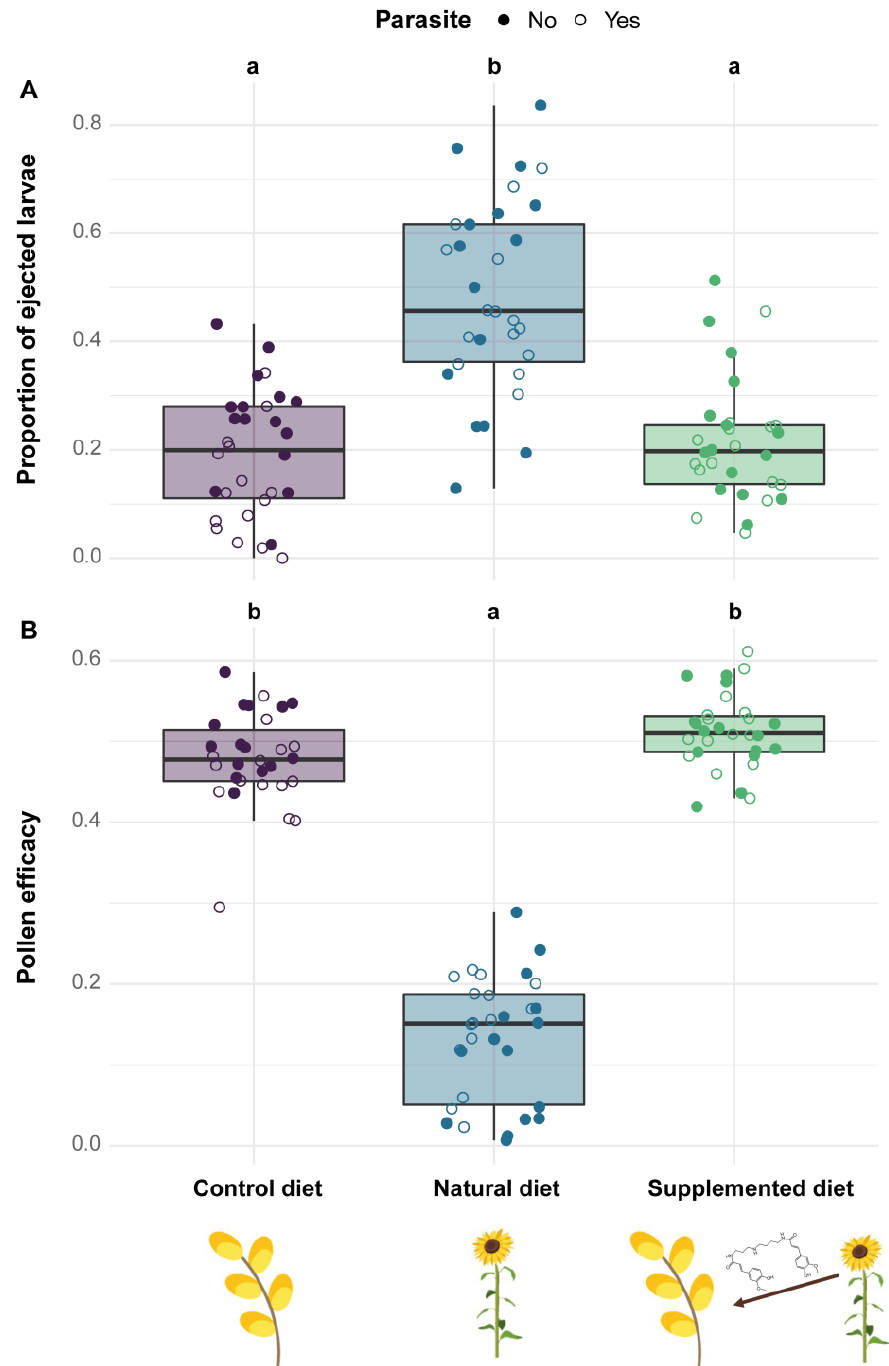
Figure 3. Stress responses in microcolonies across treatments. ( A ) Proportion of ejected larvae (i.e., number of ejected larvae divided by the total number of living offspring). ( B ) Pollen efficacy (i.e., the mass of hatched offspring divided by total mass of collected pollen). Two treatments sharing a letter are not significantly different (GLMMs).